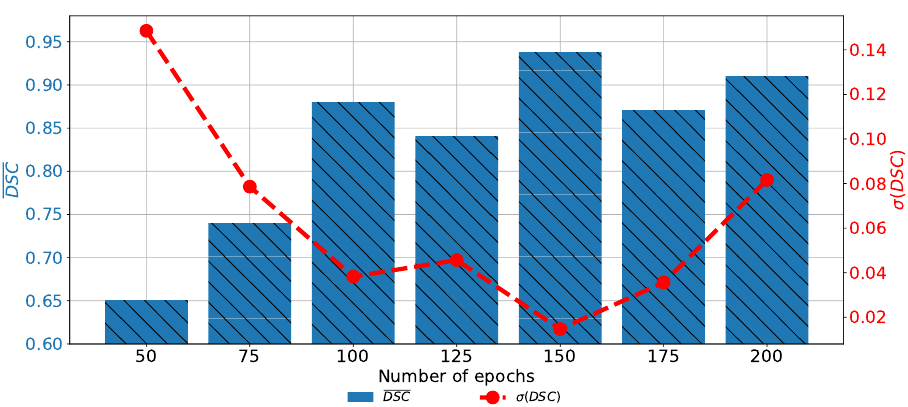
Figure 13. The change of DCS and σ ( DSC ) through a number of epochs achieved with a pre-trained ResNet50 architecture as U-net backbone for the semantic segmentation of urinary bladder cancer masses from CT images in axial plane.